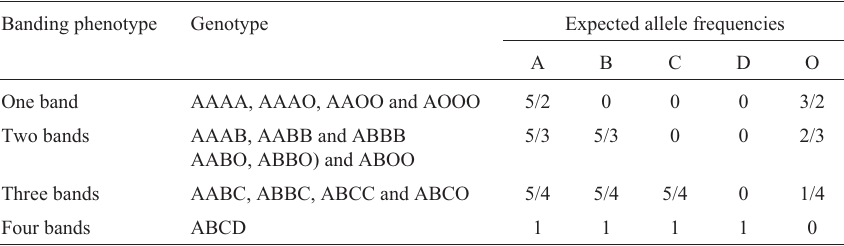
Table1 -Relationshipbetweenmarkerbandingphenotypesandgenotypesatasinglelocus.Differentlettersrepresentdifferentalleles,with‘O’denoting the null allele. The expected allele frequencies were calculated on the assumption that the frequencies of each genotype of the same banding phenotype ( i.e. numberofbandspresentontheelectrophoresisgelafterstaining)areequivalentinnaturalpopulationsofcultivatedalfalfa.Forexample,forthe‘One band’ banding phenotype all corresponding genotypes (AAAA, AAAO, AAOO and AOOO) share the same genotype